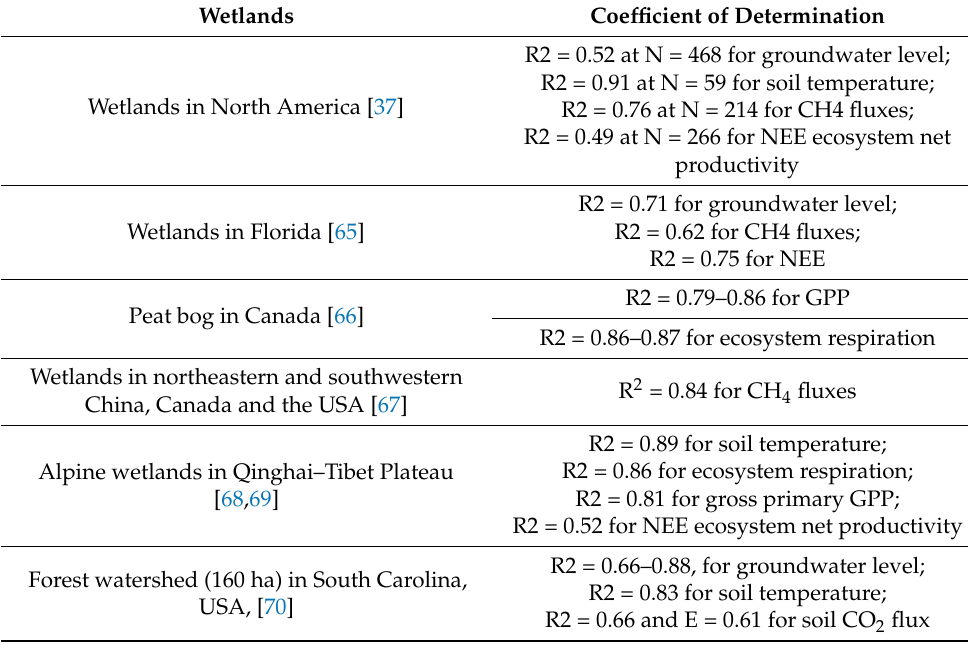
Table 3. Effectiveness of the Wetland-DNDC simulation